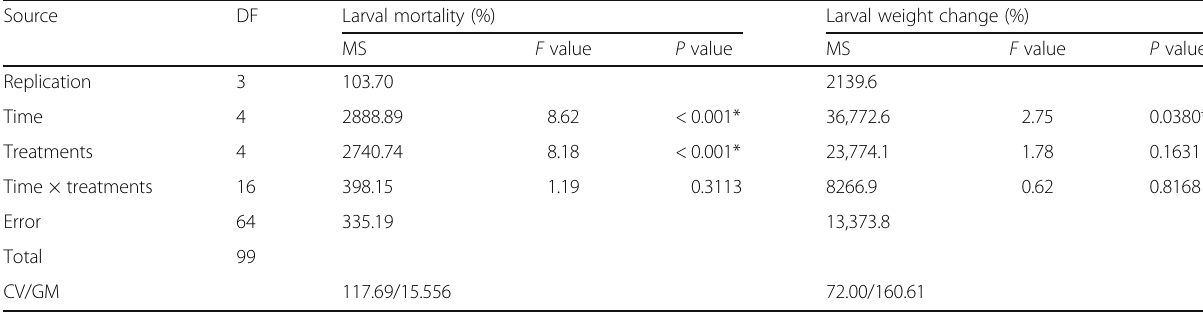
Table 1 Analysis of variance comparison of mortality of the third-instar larvae of Helicoverpa armigera Hübner bioassayed with soil isolated strain of Bacillus thuringiensis applied with 1.0% MgCl 2 salt Source DF Larval mortality (%)